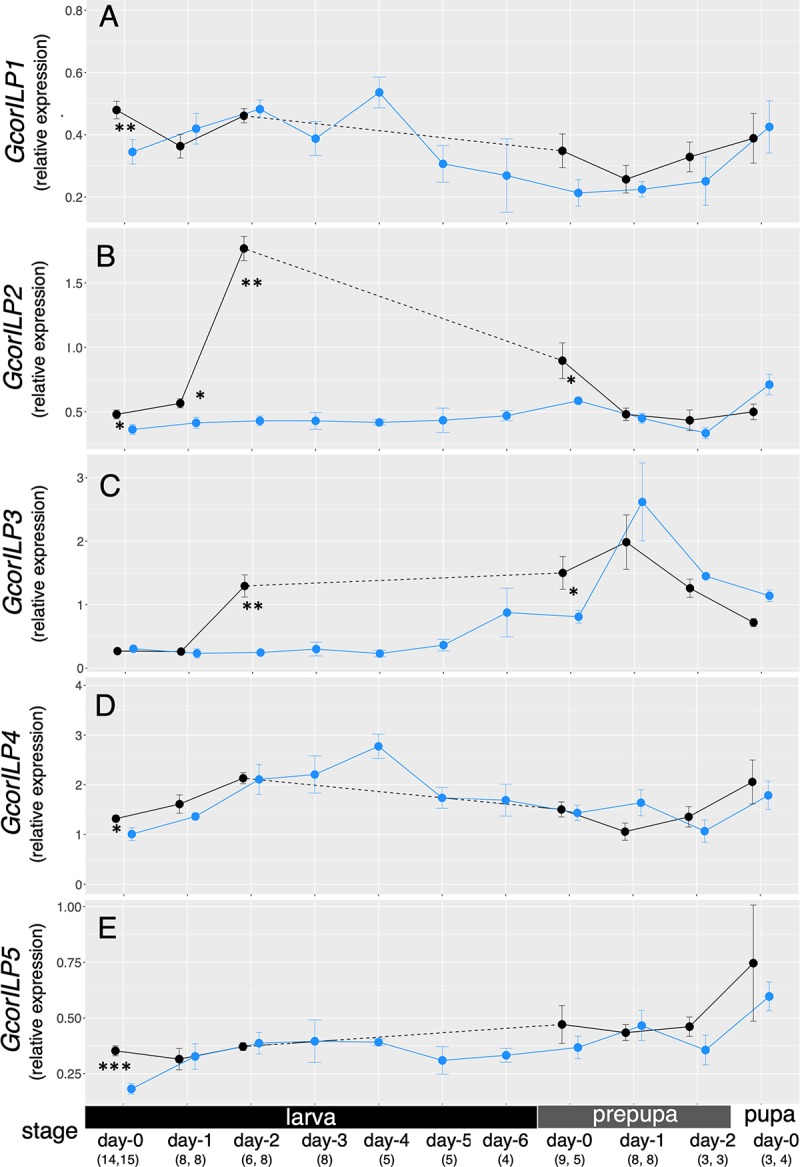
Developmental dynamics of insulin-like peptide transcription.GcorILP expression levels relative to Gcorgapdh were quantified by qPCR for the whole body. Black: large larvae; blue: small larvae. Results are presented as mean ± SE. Asterisks show significant differences between large and small larvae of the same stages (Mann-Whitney U test, *p < 0.05, **p < 0.01, ***p < 0.001). Larvae day-0 to day-6 corresponds to the days after larval isolation from culture. Prepupae day-0, -1, -2, and pupae day-0 correspond to the days after prepupation and pupation. Since large larvae take fewer days for prepupation (see Fig 1, S1 Fig), there were no large 3–6-day larvae (dashed line). The number of replicates is shown in parentheses. The underlying data in this figure are available from figshare (DOI: 10.6084/m9.figshare.9734780; https://figshare.com/s/609486022a3df39169bf). Gcorgapdh, G. cornutus glyceraldehyde 3-phosphate dehydrogenase; GcorILP, G. cornutus insulin-like peptide; qPCR, quantitative PCR.